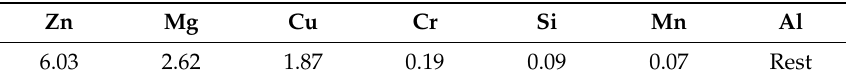
Table 1. Composition of machined alloy (mass